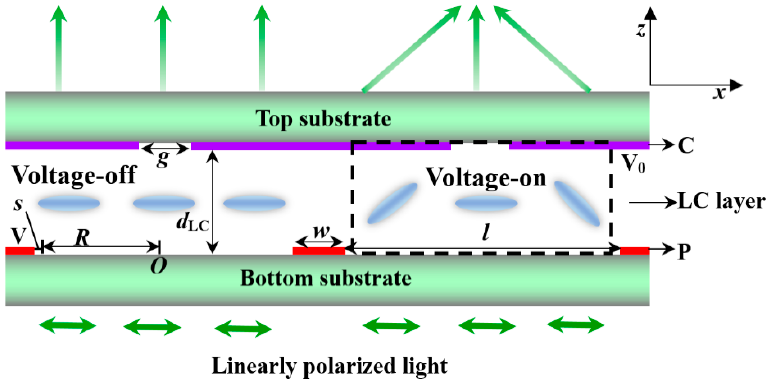
Figure 1. The configuration of the proposed liquid crystal microlens array (the area of the individual microlens is marked by a black dotted frame).